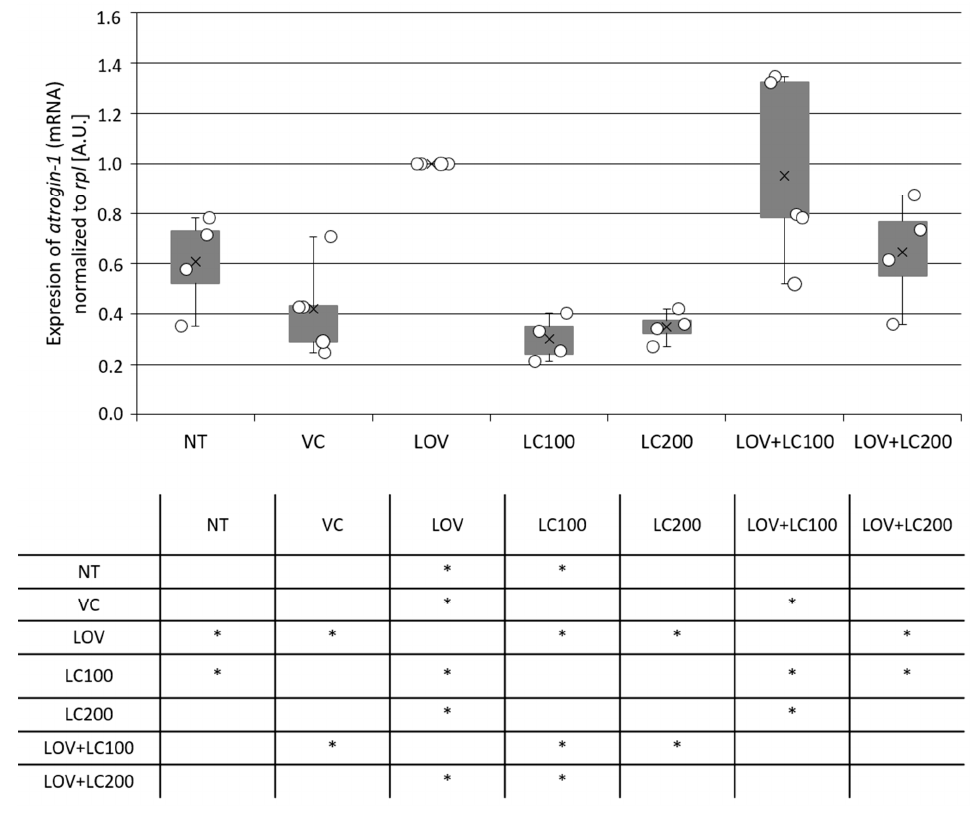
Figure 3. Real ‐ time quantitative PCR (RT qPCR) of atrogin ‐ 1 mRNA expression level in the whole body of 120 hpf zebrafish larvae exposed to lovastatin (LOV) and L ‐ carnitine (LC) treatment. Bar